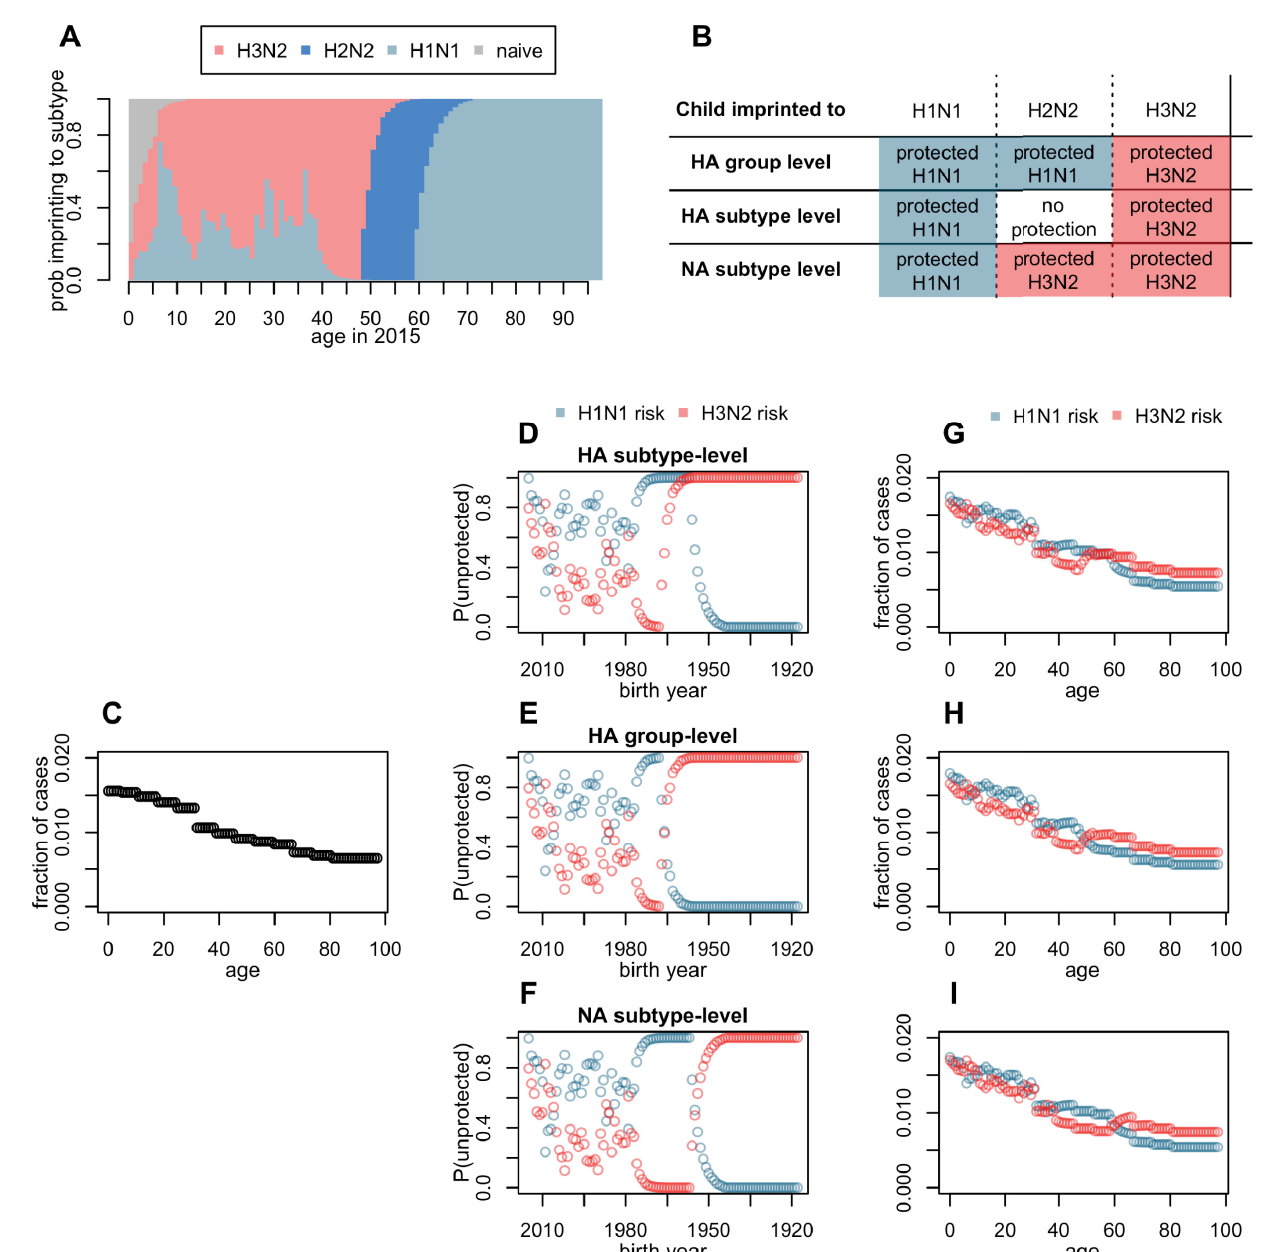
Fig 1. Model and expectations under different imprinting hypotheses. (A) Reconstructed, birth year-specific probabilities of imprinting (representative example specific to cases observed in 2015). Throughout the manuscript, group 1 HA subtypes are represented in blue and group 2 subtypes in red. (B ) Expected imprinting protection against H1N1 or H3N2 under the three tested models. ( C ) Cartoon of expected age distribution of any influenza case, before controlling for subtype-specific imprinting. The shape of this curve is purely hypothetical, but each of our tested models combined demographic age distribution with a fitted, age-specific risk step function to generate similar, data-driven curves. ( D - F) Fraction of each birth year unprotected by their childhood imprinting (from A) determines the shape of birth year-specific risk. ( G-I) A linear combination of demography plus age-specific risk (as in C), and birth year-specific risk (as in D-F) give the expected age distribution of H1N1 or H3N2 cases under each model.